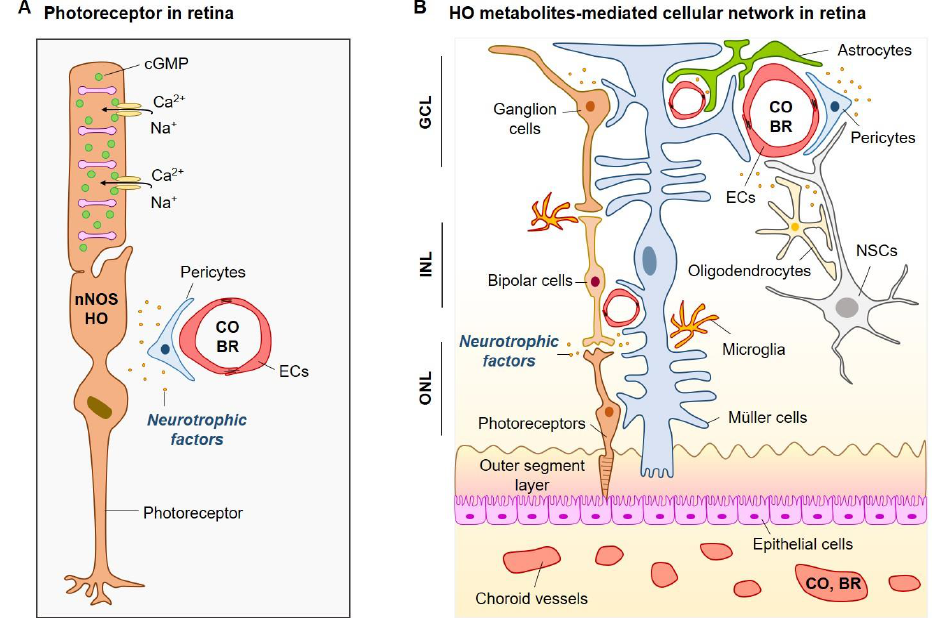
Figure 2. Possible role of HO metabolites in the retina: ( A ) HO metabolites may activate cyclic guanosine monophosphate (cGMP)-gated channels in photoreceptors partly via crosstalk between perivascular cells and photoreceptors. In the presence of HO metabolites, cGMP levels in the